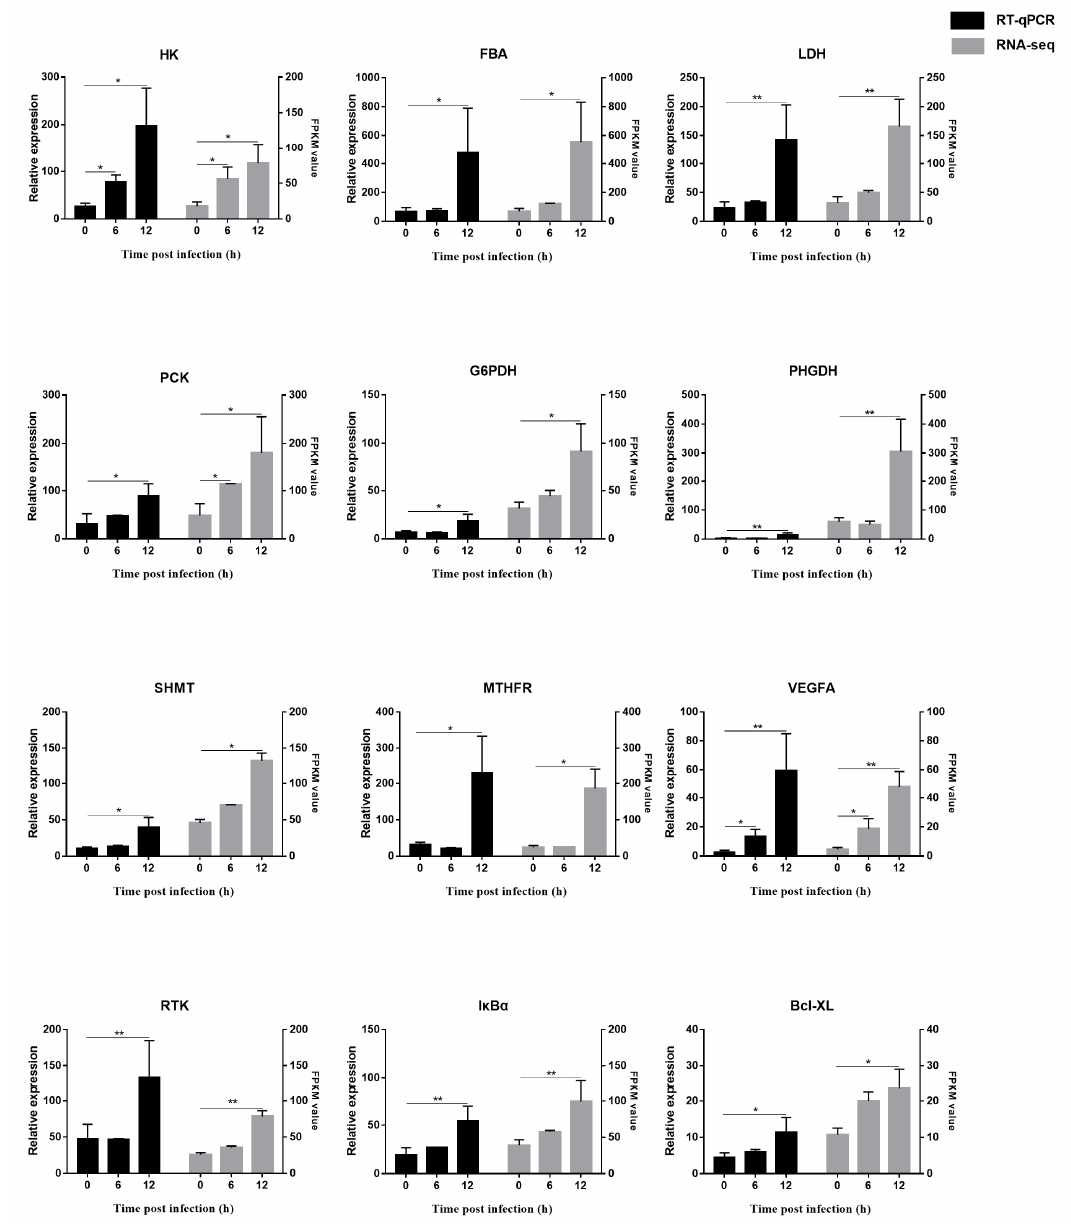
Figure 6. RT-qPCR and RNA-seq results of twelve DEGs in hepatopancreas. The data were calculated as the mean ± SD relative to the reference gene (18S rRNA). The significant statistical difference was marked with * ( p < 0.05) or ** ( p < 0.01).